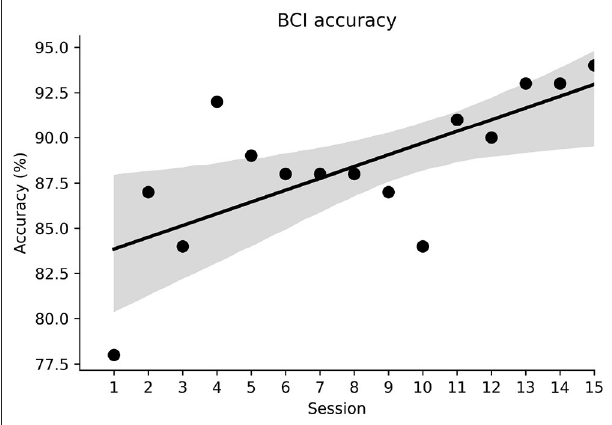
FIGURE 4 | BCI classification accuracy across sessions. The shaded area represents the 95% confidence interval.